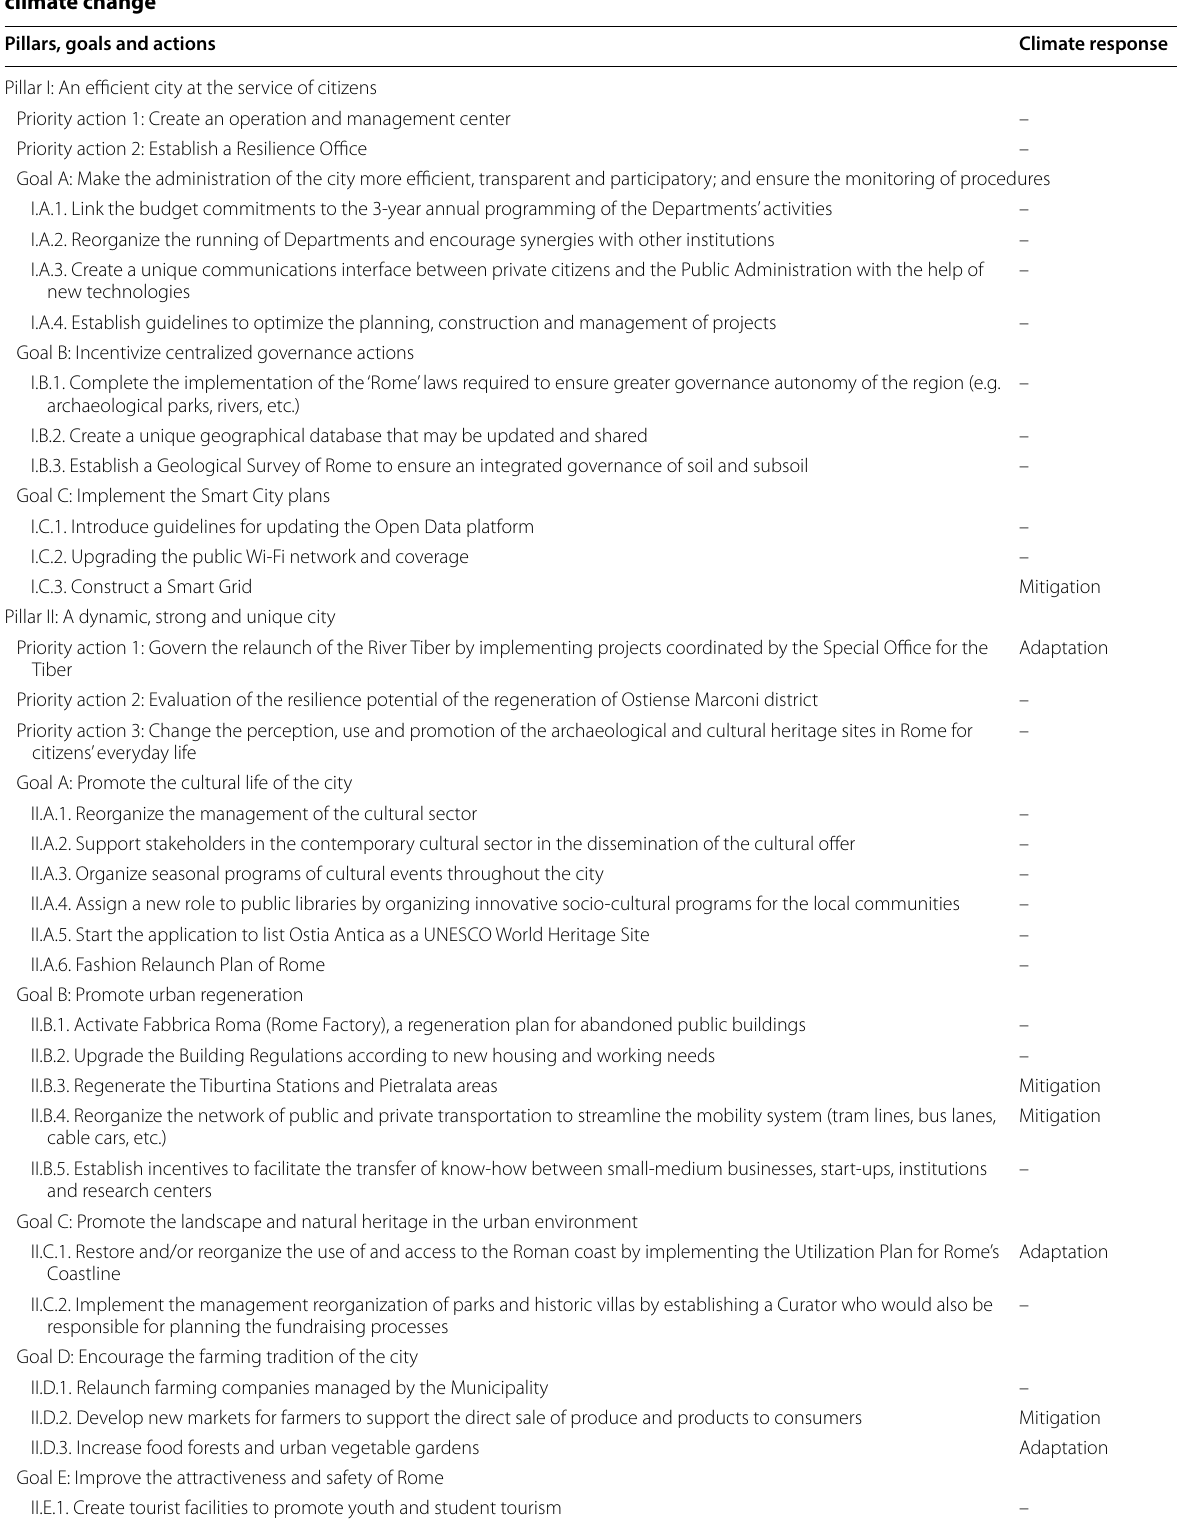
Table 1 The whole set of actions outlined by the Rome Resilience Strategy and those addressed to counterbalance climate change Pillars, goals and